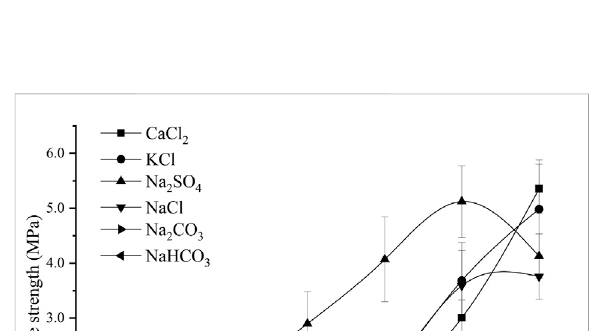
FIGURE 2 Side view photographs of Na 2 CO 3 and NaHCO 3 salt crusts (E, F represent Na 2 CO 3 and NaHCO 3 respectively; 1, 2, and 3 indicate salt content of 0.2, 1, and 4% respectively).